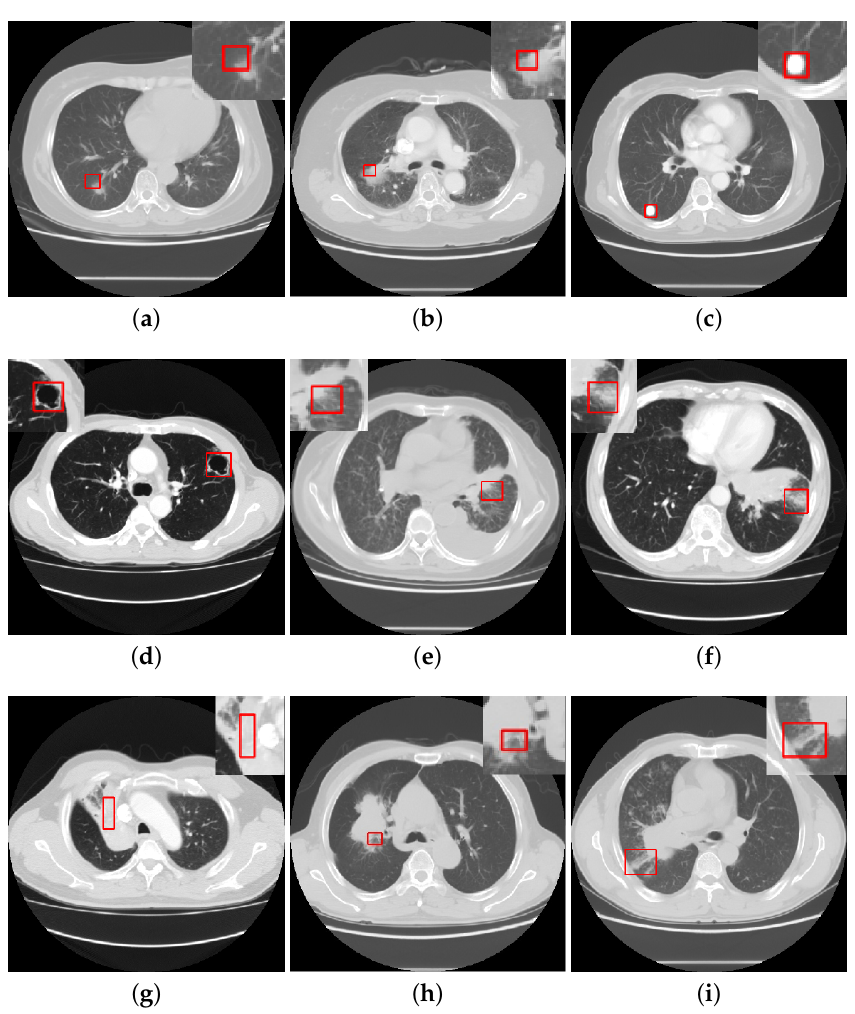
Figure 1. The examples of annotated CISs: ( a ) ground-glass opacity (GGO), ( b ) lobulation, ( c ) calcification, ( d ) cavity and vaculus, ( e ) spiculation, ( f ) obstructive pneumonia, ( g ) bronchial mucus plugs, ( h ) air bronchogram, ( i ) pleural indentation.